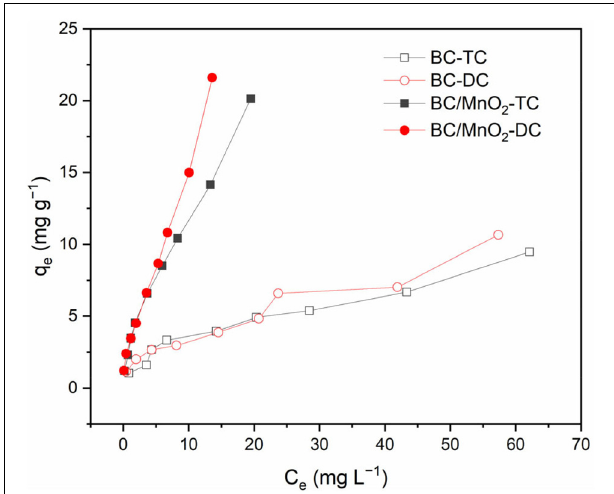
FIGURE 6 | The adsorption ability of biochar and BC/MnO 2 for TC and